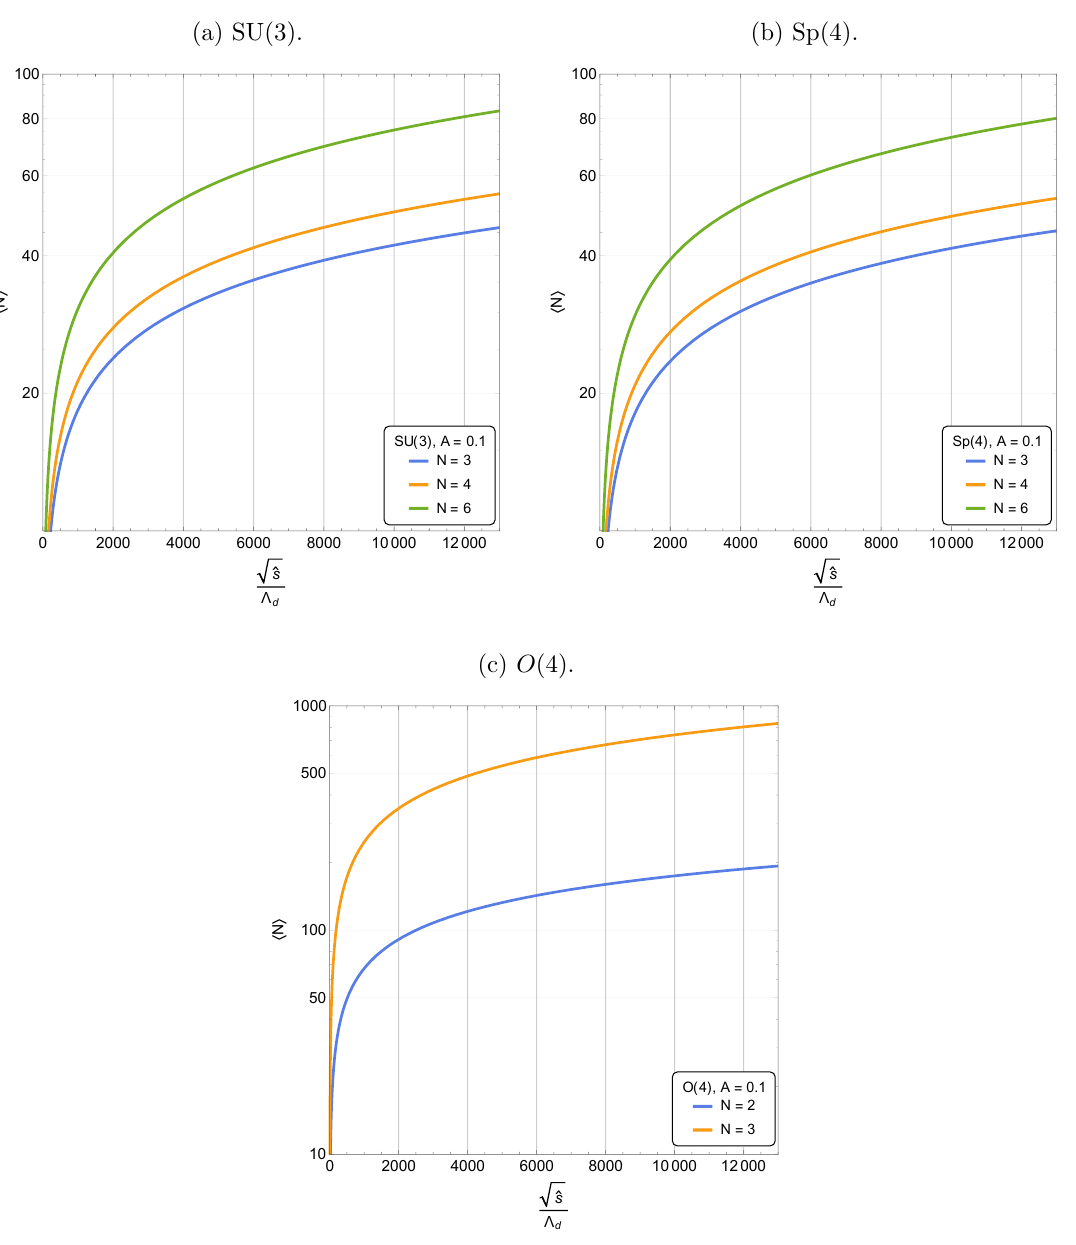
Figure 10. Theory prediction of the average dark meson multiplicity as a function of the ratio p ^ s= (cid:3) d for (a) SU(3), (b) Sp(4) and (c) O (4) for di(cid:11)erent values of N . The normalization is (cid:12)xed as A = 0 : 1.